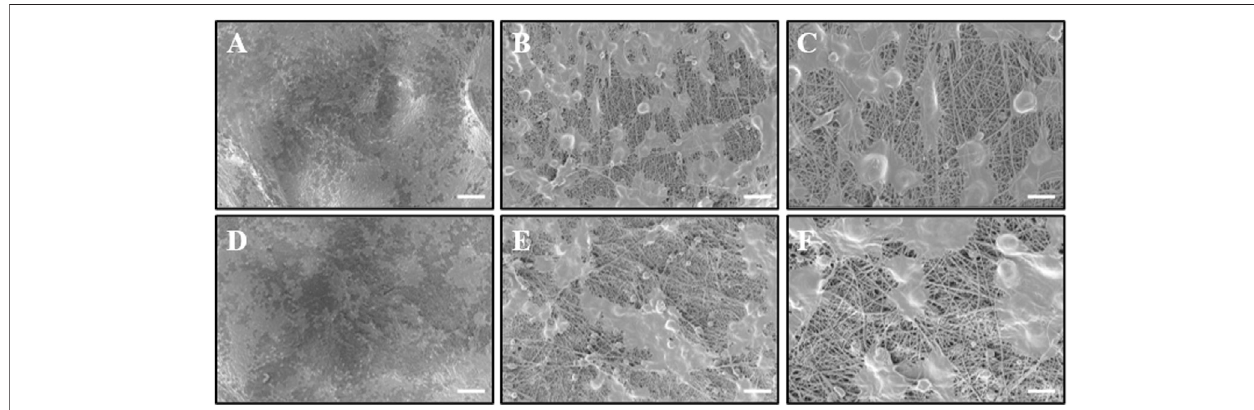
FIGURE 4 | Observation of RSC morphology on the PCL side of MXene-PCL and PCL NGC scaffolds through SEM. RSCs were seeded on the MXene side of MXene-PCL scaffold (A – C) and PCL scaffold (D – F) for 72 h before being examined by SEM. The scale bars are 100 μ m (A,D) , 20 μ m (B,E) , and 10 μ m (C,F) , respectively.